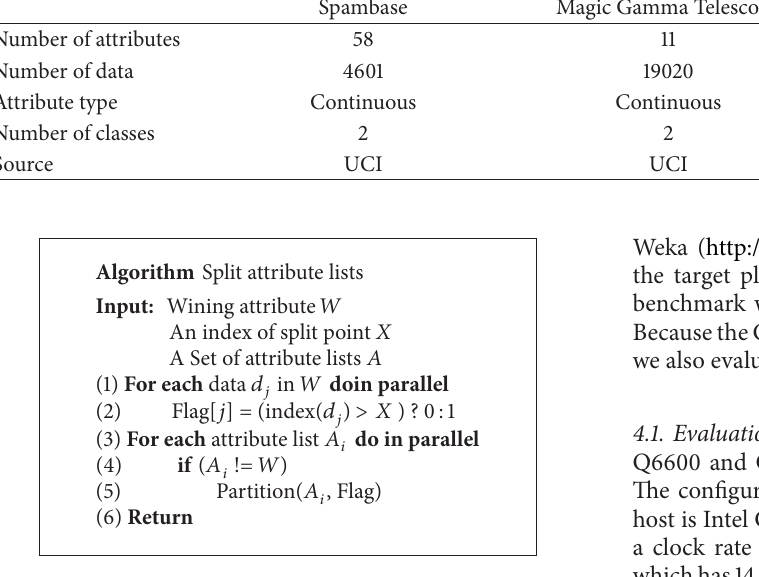
Algorithm 5: Algorithm of split attribute